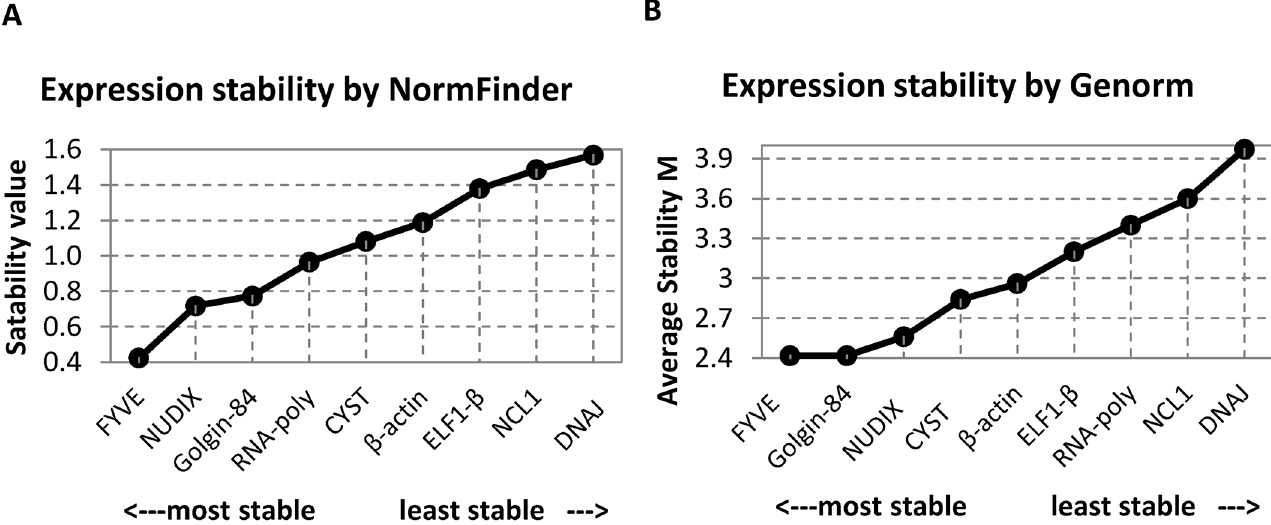
Fig 3. Stability analysis of candidate reference genes. Gene expression stability was measured in leaf tissues of soybean subjected to drought stress and control conditions at different times of day (ZT0, ZT4, ZT8, ZT12, ZT16 and ZT20). The analysis was performed with NormFinder and geNorm softwares. Genes were ranked according to their stability values and M values from (A) NormFinder and (B) geNorm, respectively. The genes were plotted on the x-axis from the most to the least stable.